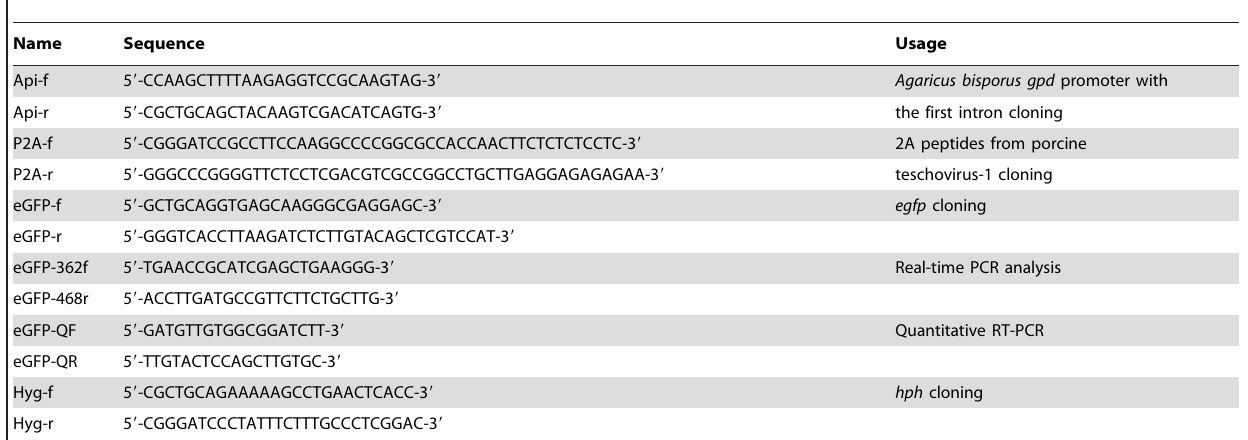
Table 1. Primers used in this